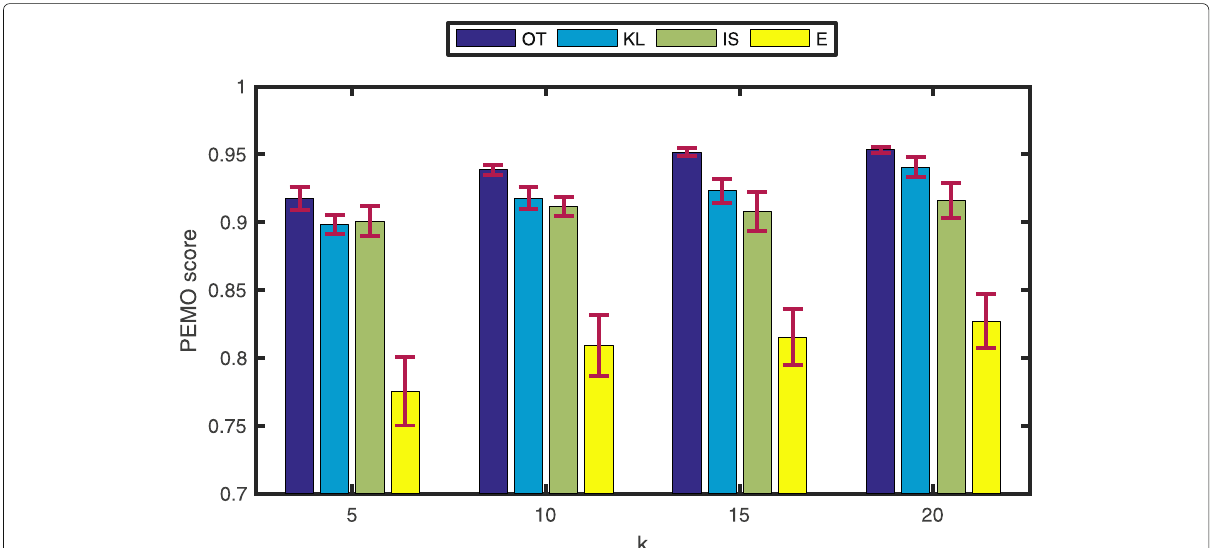
Fig. 5 Perceptive quality score (universal voice model). Average and standard deviation of PEMO scores of reconstructed isolated voices, where the model is learned using the same training data for all voices with optimal transport (dark blue), Kullback-Leibler (light blue), Itakura-Saito (green), or Euclidean (yellow)